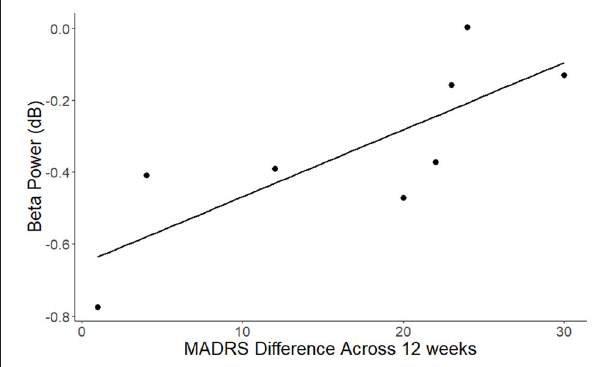
FIGURE 3 | Association between change in MADRS scores across the nicotine treatment period and beta power for standard trials over the parietal cluster ( r = 0.8, p < 0.02). Beta values reflect decreases compared to the pre-stimulus baseline.